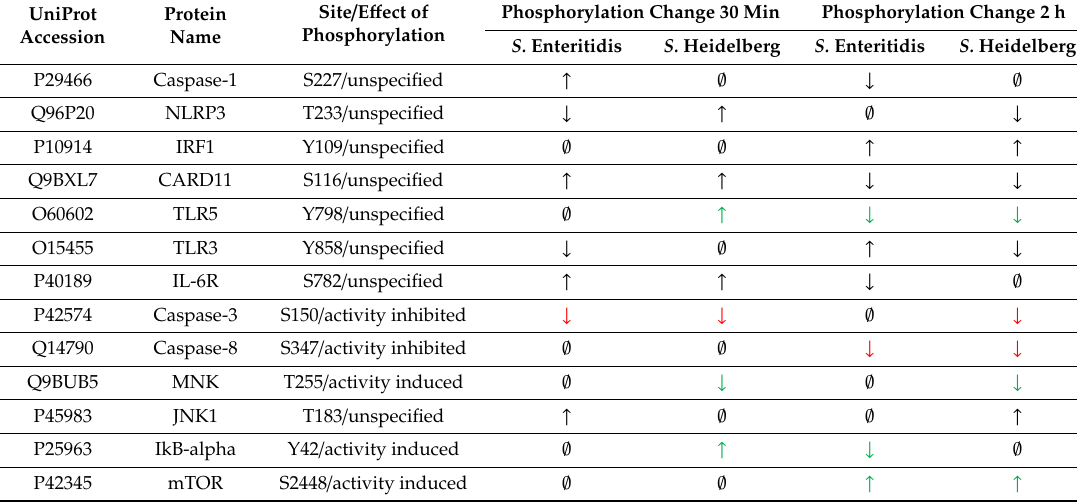
Phosphorylation changes in major immune and immunoregulatory proteins during S. Enteritidis and S. Heidelberg infection of chicken